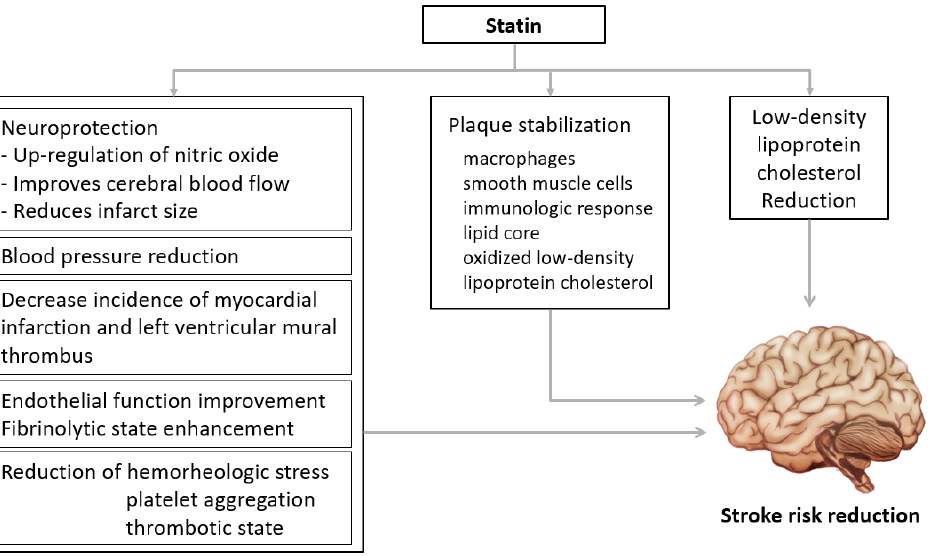
Figure 1. Beneficial effects of statins. Statins have pleiotropic effects such as improvement of vascular endothelial cell function, improvement of nitric oxide bioavailability, antioxidant effects, inhibition of in fl ammatory response, and stabilization of atherosclerotic plaques. Side e ff ects of statins: The notable side e ff ects of statins are diabetes mellitus, muscle